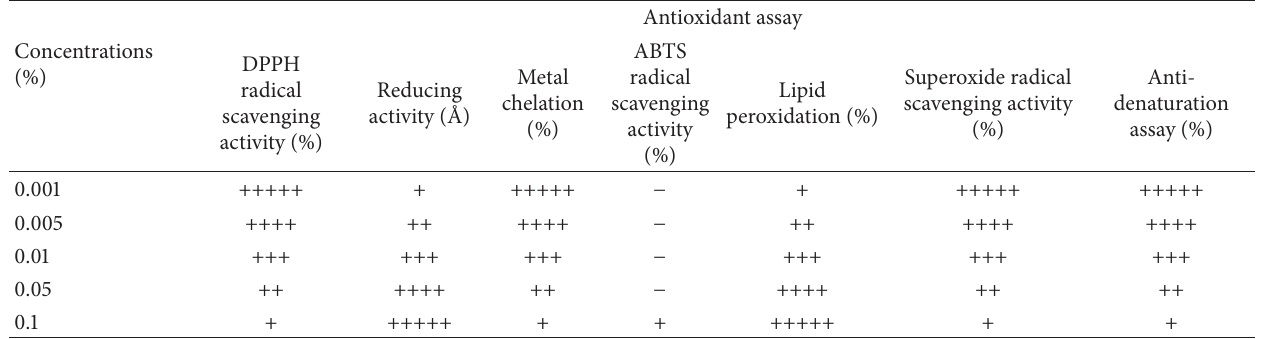
Table 1: Relative efficacy of each antioxidant assay for individual antioxidant concentration.